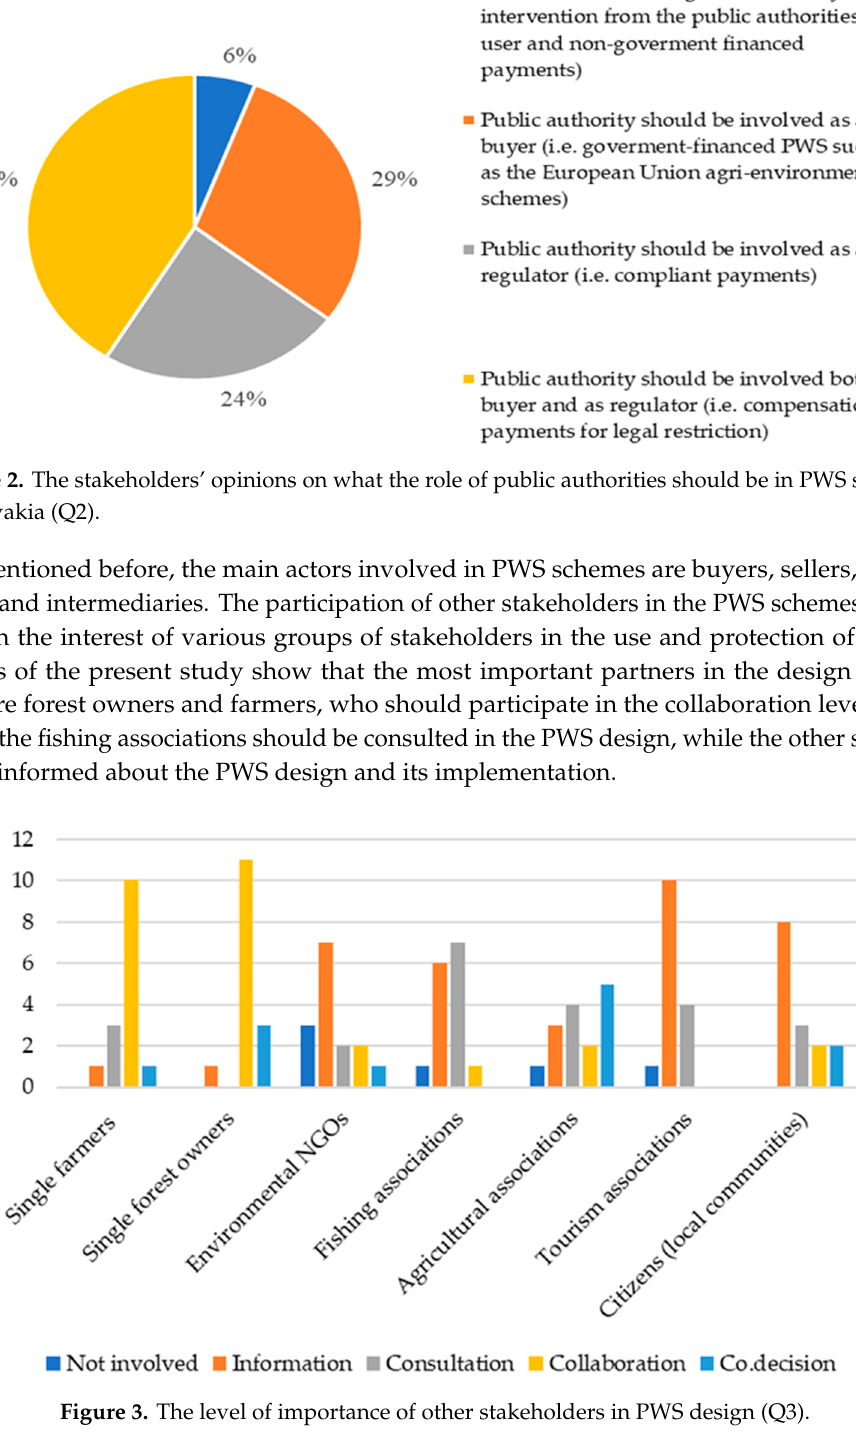
Figure 3. The level of importance of other stakeholders in PWS design (Q3).